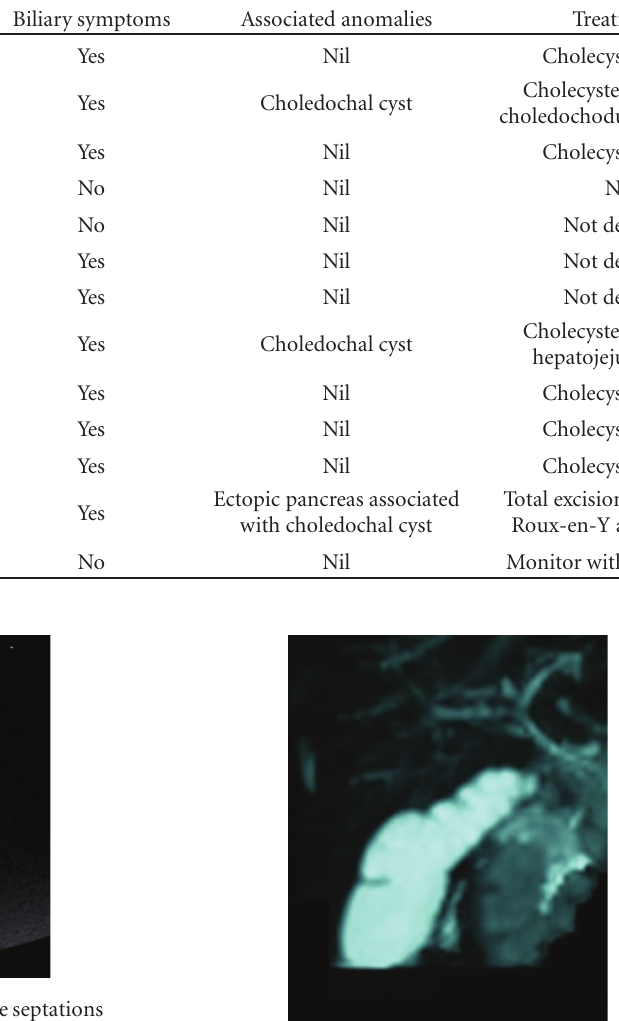
Figure 1: Ultrasound image demonstrating multiple fine septations within the gallbladder.